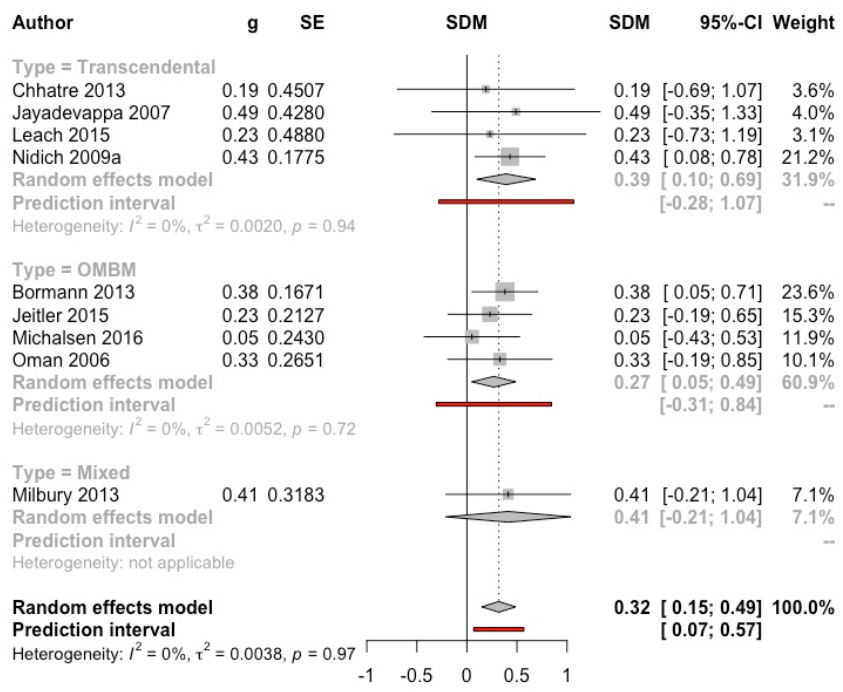
Figure 10. Effect on mental health-related quality of life (meditation vs. control). Predictive intervals are represented in red.